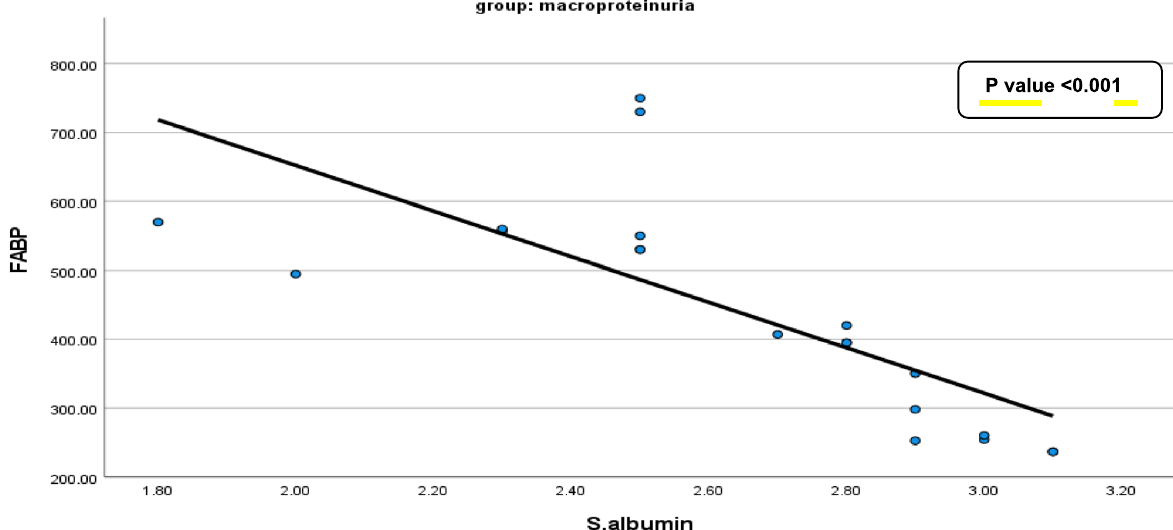
Fig. 3 Correlation between serum FABP4 and serum albumin in the macroalbuminuria